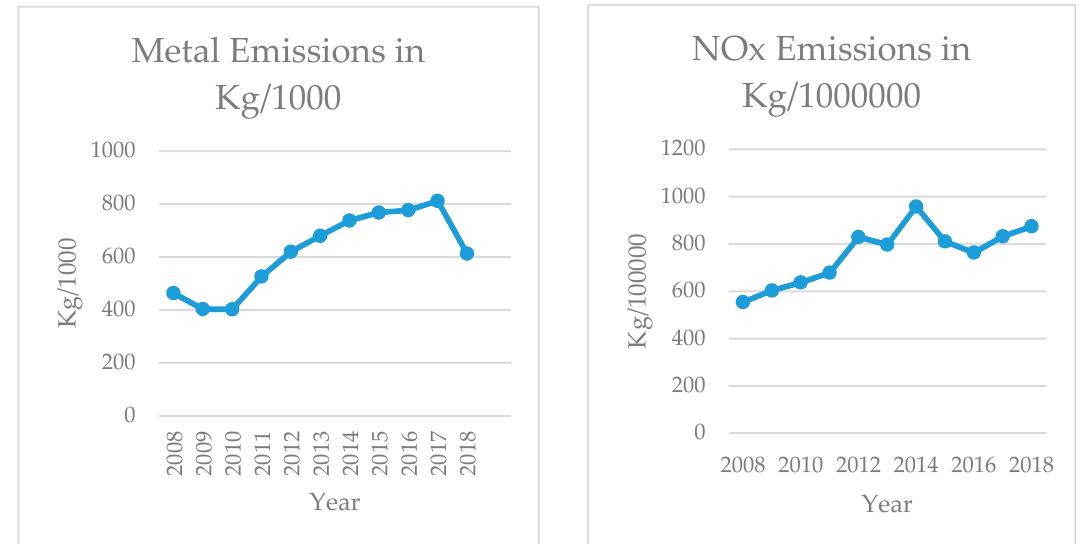
Figure 2. Air pollution emissions from coal mining sites, 2008–2018.